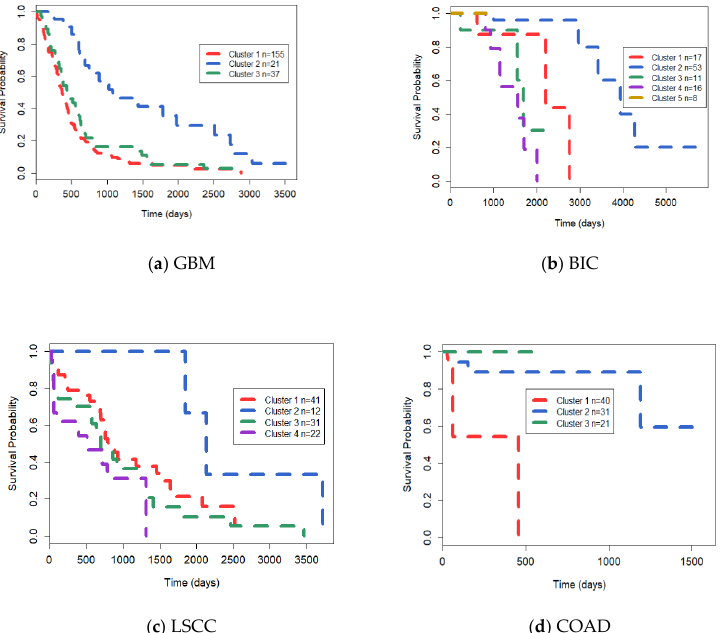
Figure 2. The Kaplan–Meier survival curves of ( a ): Glioblastoma Multiforme (GBM), ( b ): Breast Inva- sive Carcinoma (BIC), ( c ): Lung Squamous Cell Carcinoma (LSCC) and ( d ): Colon Adenocarcinoma (COAD),